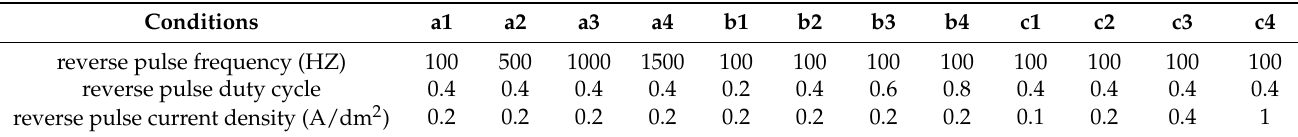
Figure 2. The schematic diagram of forward- and reverse-pulse currents to prepare copper, +j p is the forward pulse current density, − j p is the reverse pulse current density, t on is the pulse current on-time, t off is the pulse current off-time, T is a pulse power-on and power-off cycle, T = t on + t off , TF is the working time of a set of forward pulses, and TR is the working time of a set of reverse pulses. Table 1. Experimental parameter